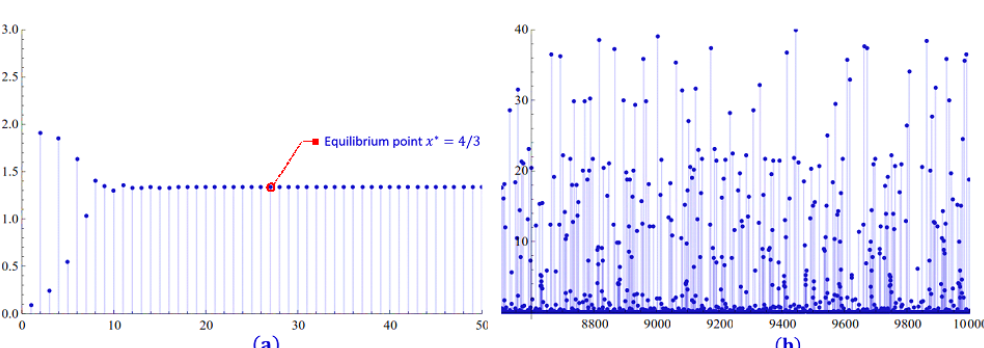
Figure 3. ( a ) Locally asymptotically stable, ( b ) unstable saddle point.